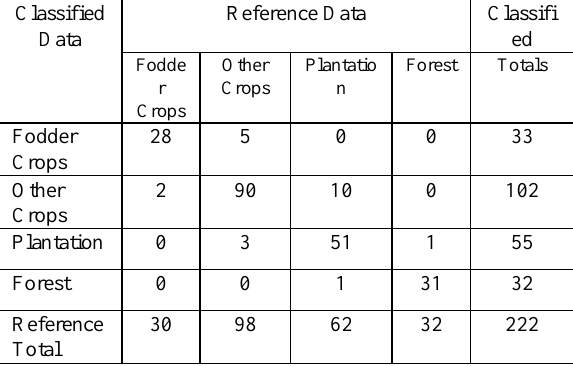
Table 1: Confusion Matrix for SVM (RBF-kernel)